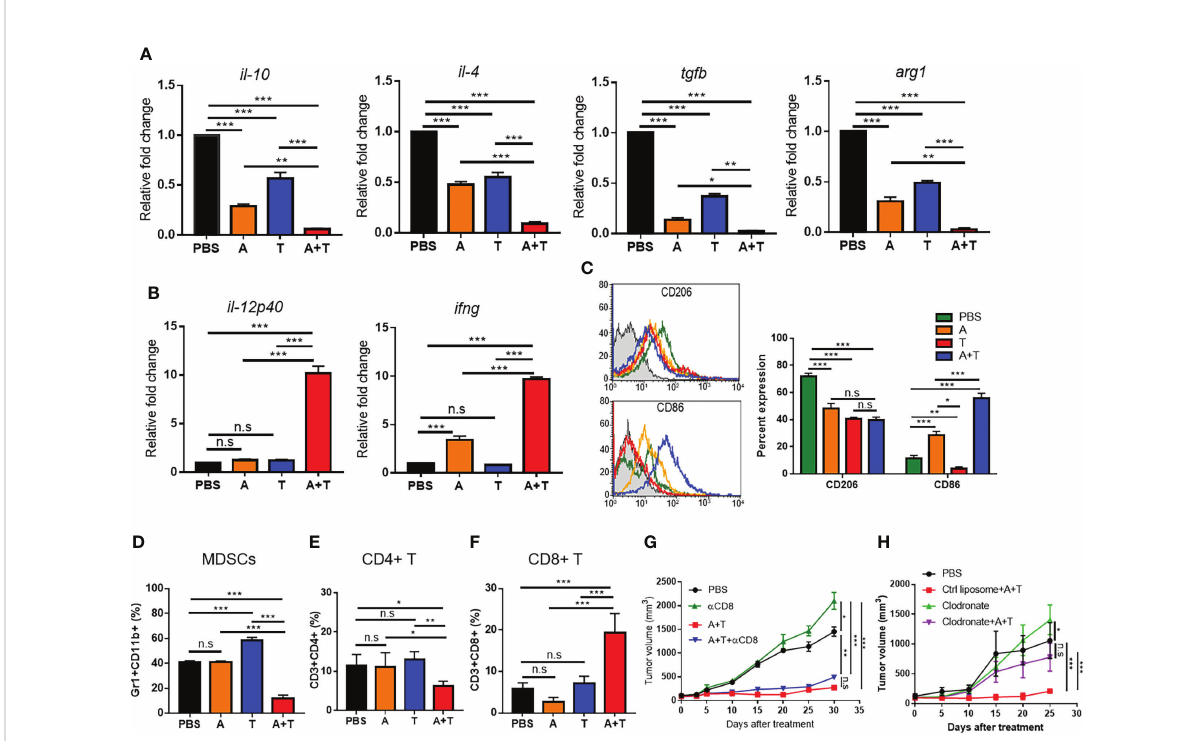
FIGURE 4 Epigenetic therapy with the combination of 5-aza-dC and TSA promotes reprogramming of M2-type TAMs into the M1-like phenotype in the tumor microenvironment. (A, B) qRT-PCR analysis of the relative mRNA levels of M2- (A) and M1-type (B) cytokines and markers in tumor tissues after treatment of 4T1 tumor-bearing mice with 5-aza-dC (referred as A) and TSA (referred as T), alone or in combination (A+T). ( C – F) Flow cytometric analysis of the population of CD206 + M2 macrophages and CD86 + M1 macrophages (C) , CD11b + Gr1 + MDSCs (D) , CD4 + T cells (E) , and CD8 + T cells (F) in the tumor tissues after treatments. (G, H) Tumor volumes after treatments in the absence or presence of CD8 + T cell depletion (G) and macrophage depletion using clodronate (H) . Control (Ctrl) liposomes were used as control for clodronate. Data represent the mean ± SD of three separate experiments performed in triplicates (A – F) and three mice ( n =3) per group (G, H) . *, P <0.05; **, P <0.01; ***, P <0.001; n.s., not signi fi cant, as assessed using one-way ANOVA followed by Tukey ’ s multiple comparison post-hoc